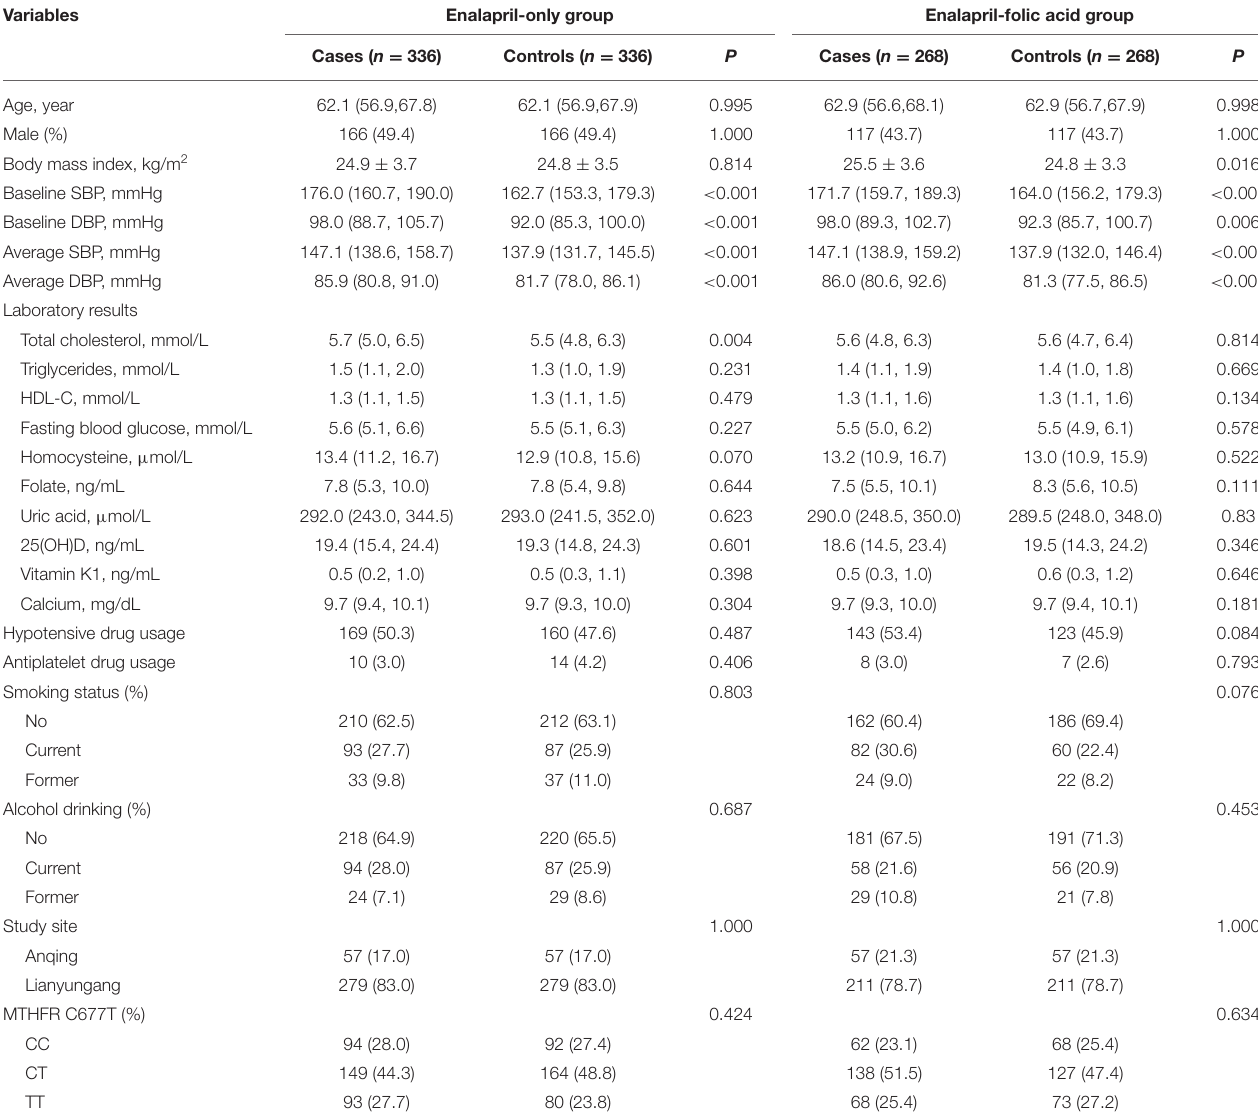
TABLE 1 | Characteristics of the participants by case-control status and by treatment group a .